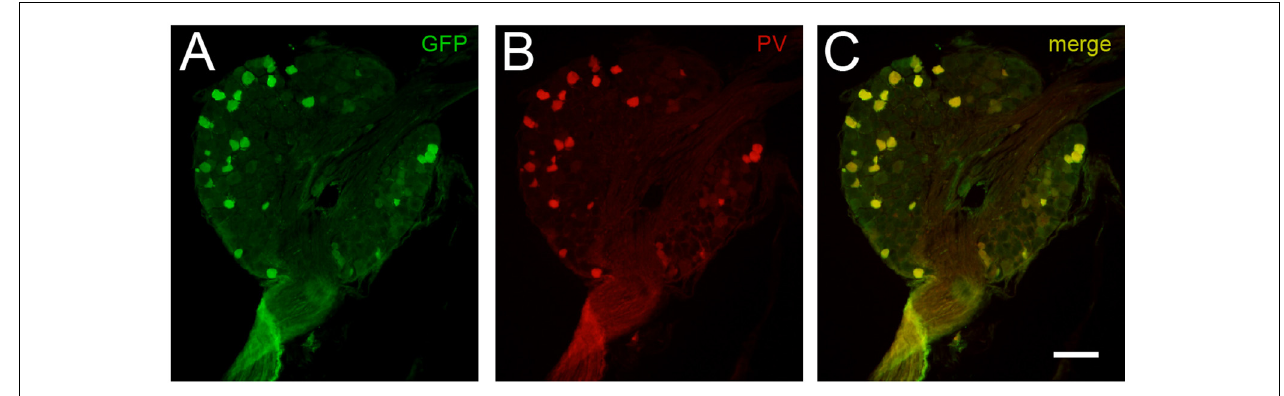
FIGURE 1 | Comparison of GFP-expression and parvalbumin (PV) immunolabeling in dorsal root ganglia (DRG) cells. The fidelity of GFP expression in PV-expressing DRG neurons was tested to confirm the utility of tissue from the PVeGFP transgenic mouse line. Panels (A,B) show a representative DRG section immunolabeled for GFP (green) and PV (red), respectively. Overlaid image (C) shows co-localization (yellow) of GFP and endogenous PV in DRG cells. This analysis showed complete overlap (100%) in 645 DRG cells examined ( n = 3 animals). Scale (A–C) = 100 µ m.